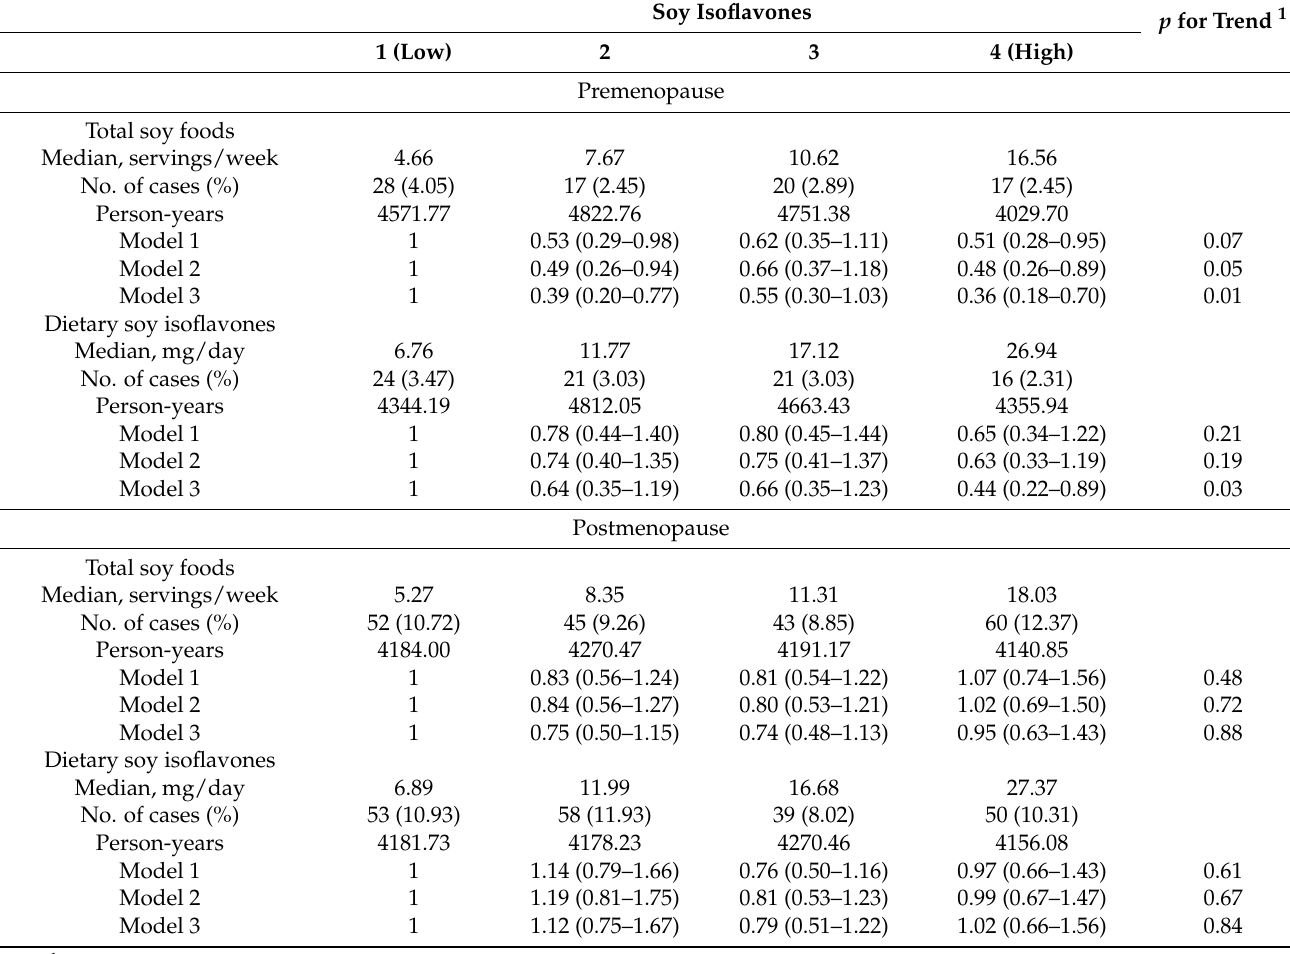
Table 3. Hazard ratios and 95% confidence intervals for cardiovascular disease by quartiles of energy-adjusted intake levels of total soy foods and dietary soy